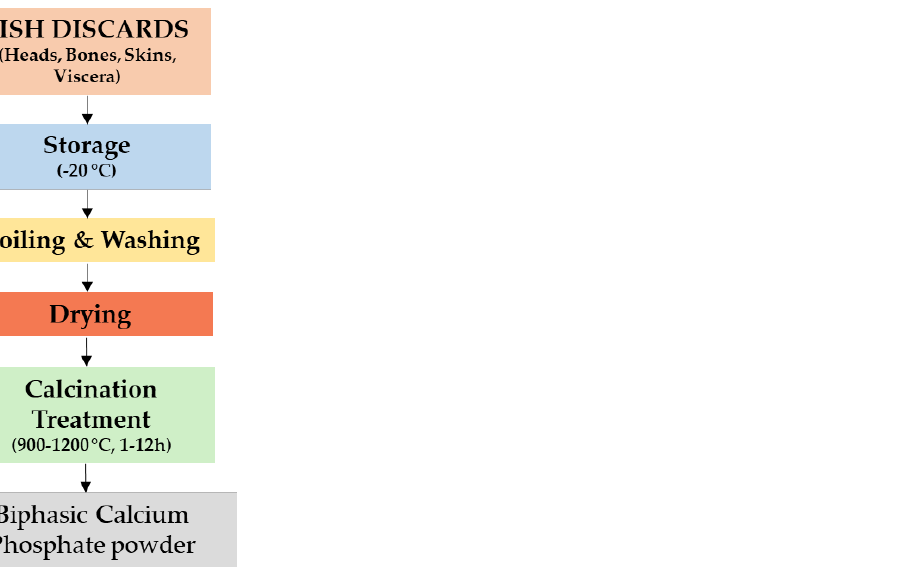
Figure 1. General flow diagram of biphasic calcium phosphate extraction from fish